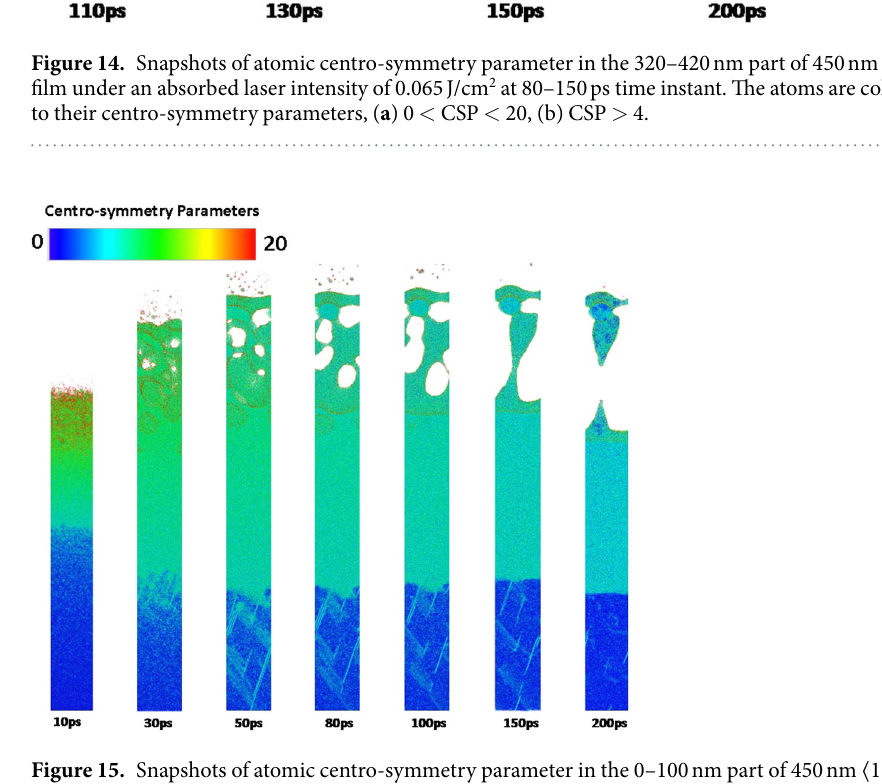
Figure 15. Snapshots of atomic centro-symmetry parameter in the 0–100 nm part of 450 nm 〈 111 〉 copper film under an absorbed laser intensity of 0.065 J/cm 2 at 10–200 ps time instant.